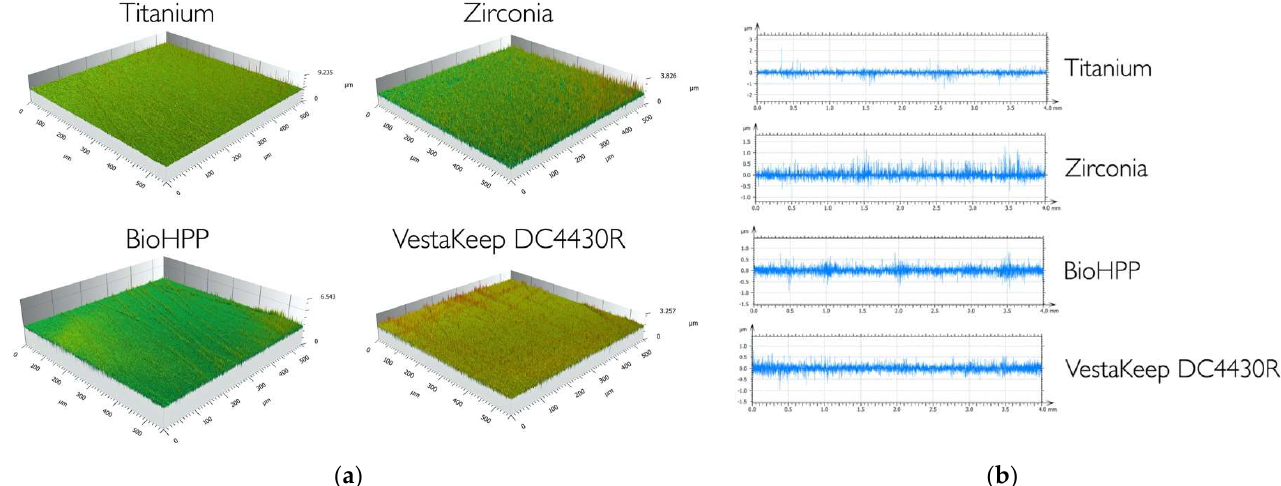
Figure 1. ( a ). Widefield confocal micrographs of the test materials, 3D-profile (500 × 500 µm 2 ). ( b ). Widefield confocal micrographs of the test materials, 2D-profile (40 mm).